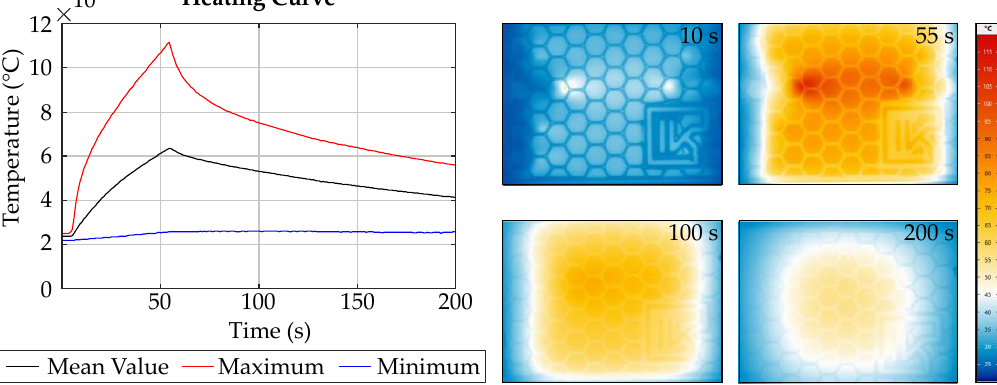
Figure 22. Representation of the heating curve at an applied voltage of 6 V with corresponding images of the heat distribution.